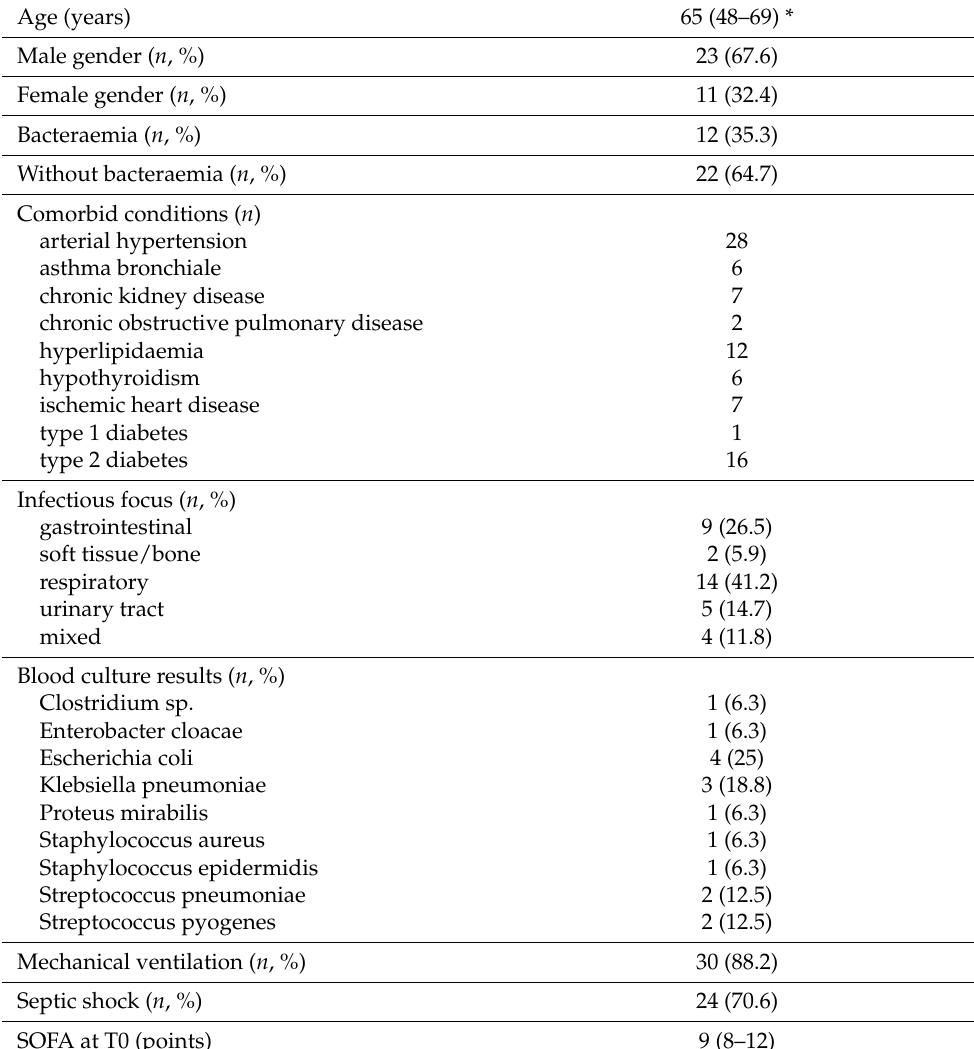
Table 2. Study population characteristics for the Sepsis